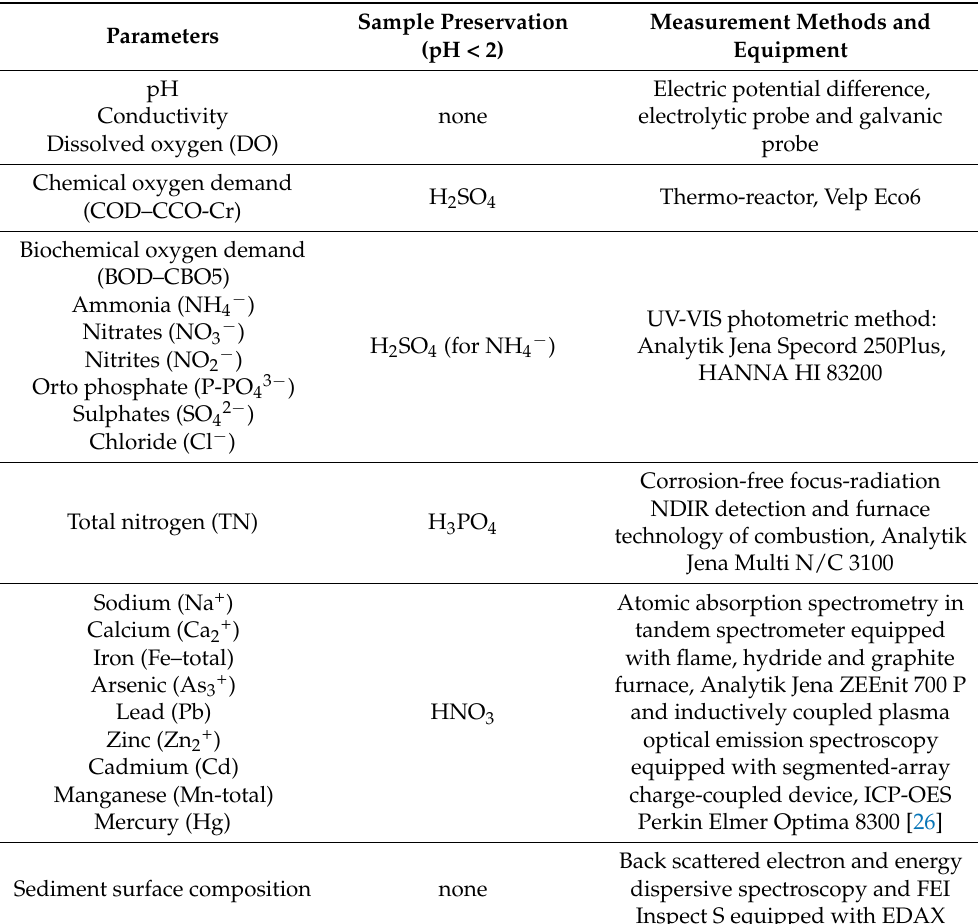
Table 1. Methods and analytical equipment used for chemical analysis of sediments and surface water